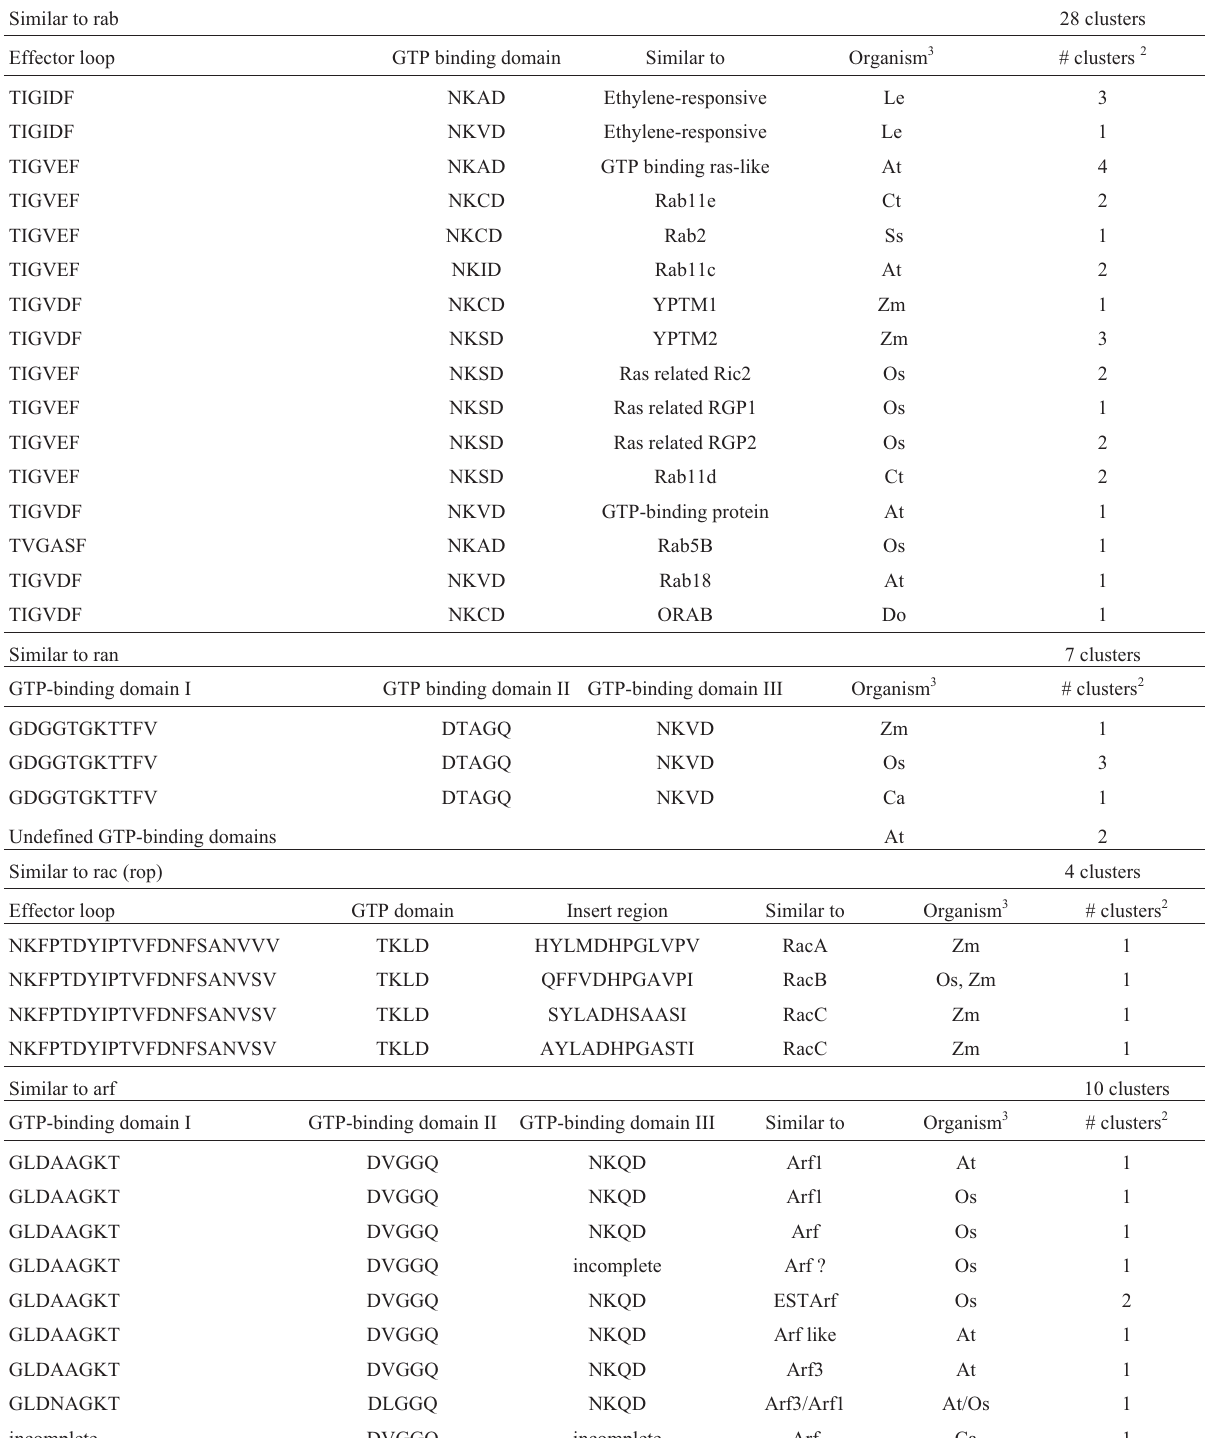
Table II - Catalogue of sugarcane small GTP-binding proteins 1